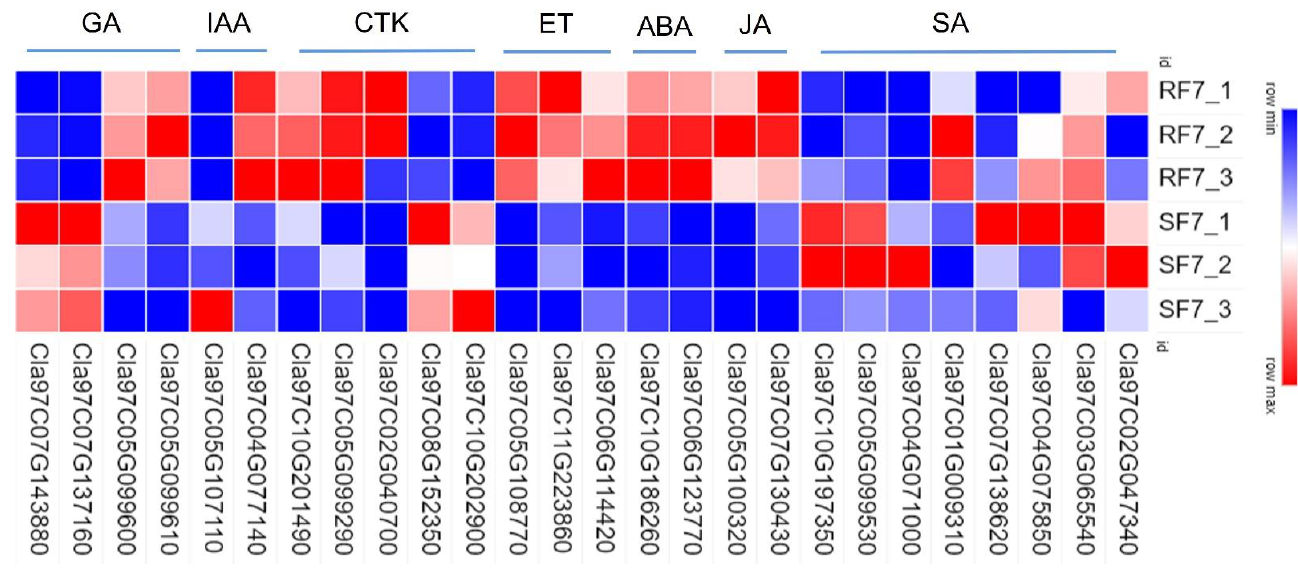
Figure 7. Comparison analysis of relative expressions of candidate genes related to phytohormone pathways in resistant and susceptible samples: GA: gibberellins; IAA: auxin; CTK: cytokinin; ET: ethylene; ABA: abscisic acid; JA: jasmonic acid; SA: salicylic acid. Note: SF7, Susceptible cultivar +FON, 7 dpi; RF7, Resistant cultivar + FON, 7 dpi. Three independent replicates.